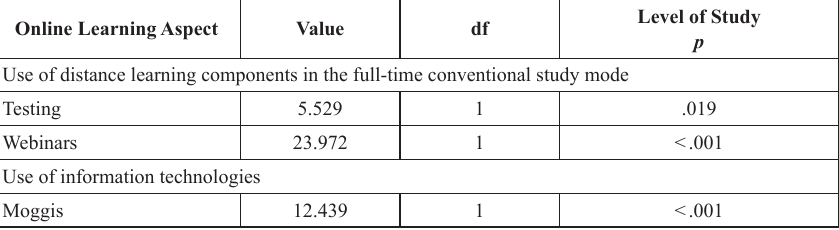
Table 12. Significance of differences between attitudes towards online learning